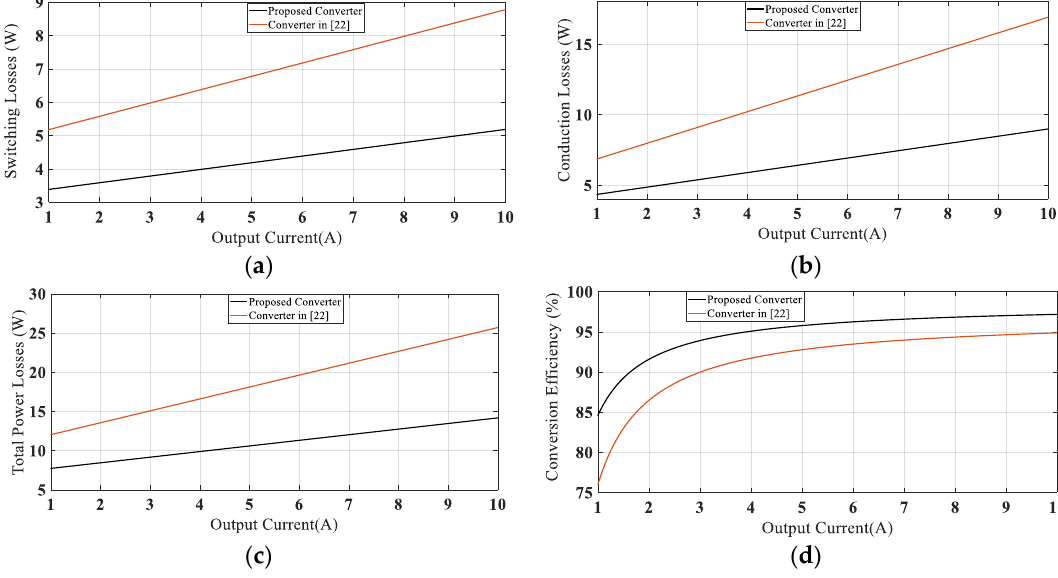
Figure 8. Comparison for ( a ) switching losses; ( b ) conduction losses; ( c ) total power losses; ( d ) conversion efficiency.